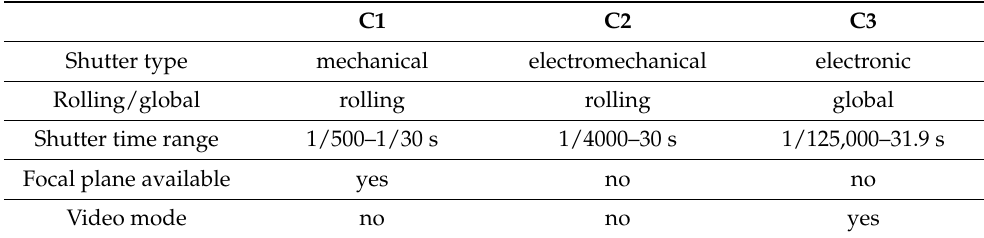
Table 1. Shutter properties of the cameras used for testing in the